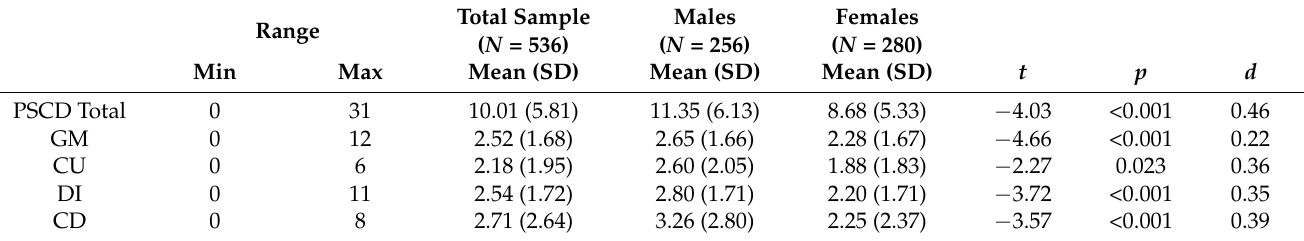
Table 3. Descriptive statistics of the PSCD subscales and total score, with gender